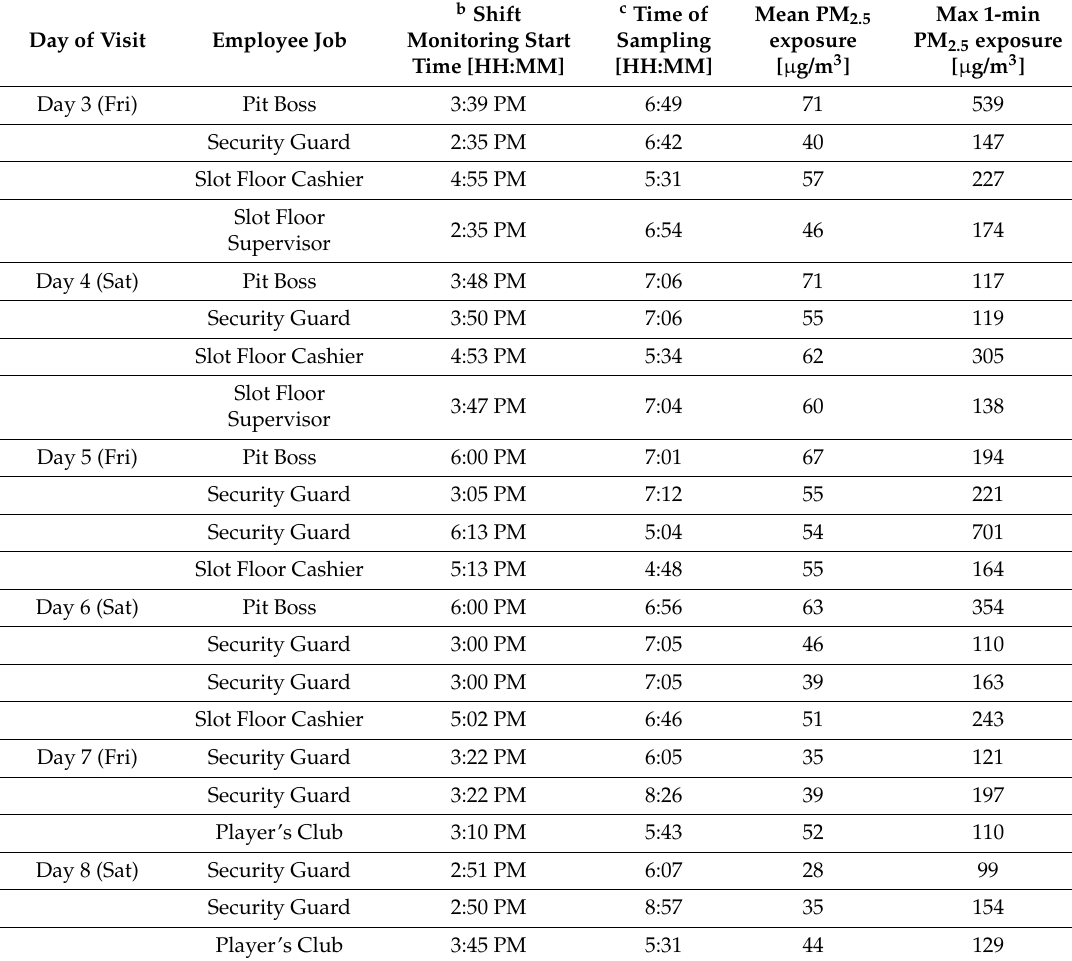
Table S4. Mean and 1-min maximum personal PM 2.5 exposures for individual Win-River Casino employees in 2008 and 2011 by day of visit a